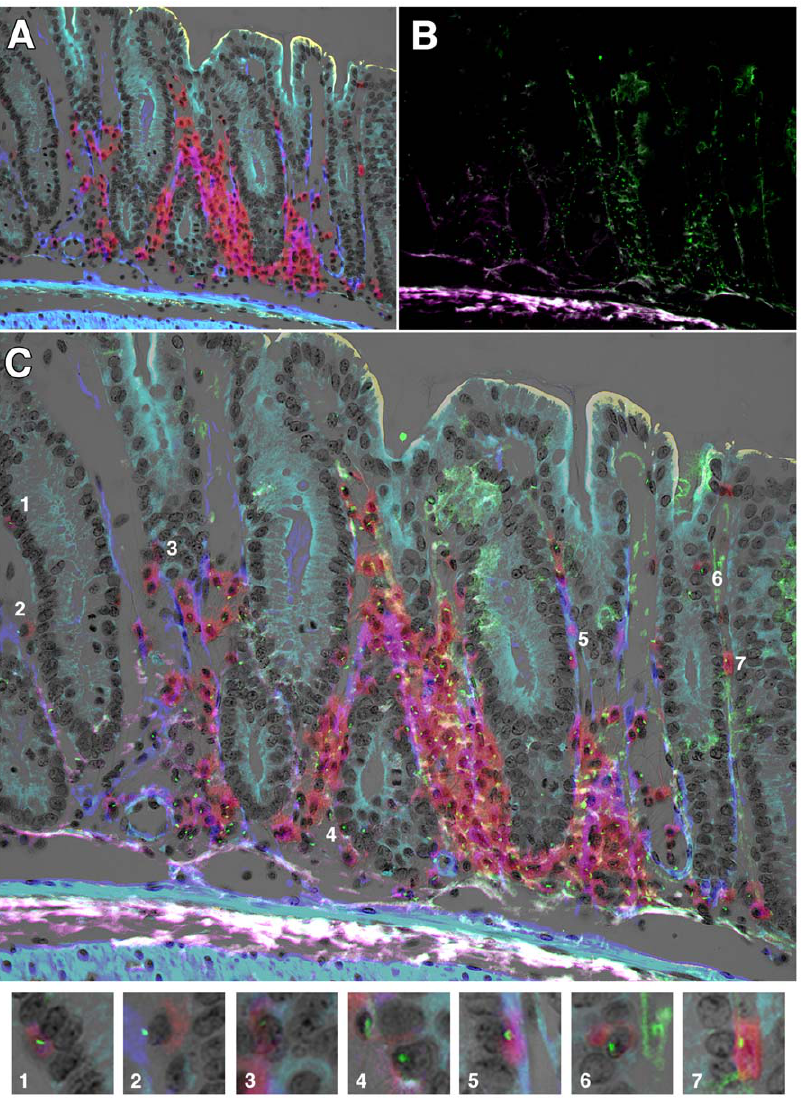
Figure 4. Double IHC with Y chromosome analysis. A. Double IHC for a -SMA (blue) and CD45 (red) in the colon of a female mouse with GvHD- like syndrome 28 days after male BMTx. Brightfield image (greyscale) overlain with fluorescent blue and red signals. B. Subsequent analysis of Y chromosome signals (green dots) on same section as A, showing some autofluorescence as pale green and white/purple. C. Overlay image of A and B with cells of interest highlighted and shown in Panels 1–7 below. Original magnifications A, B digitally reduced from 200X, C 200X. Panels further enlarged digitally to 600X.